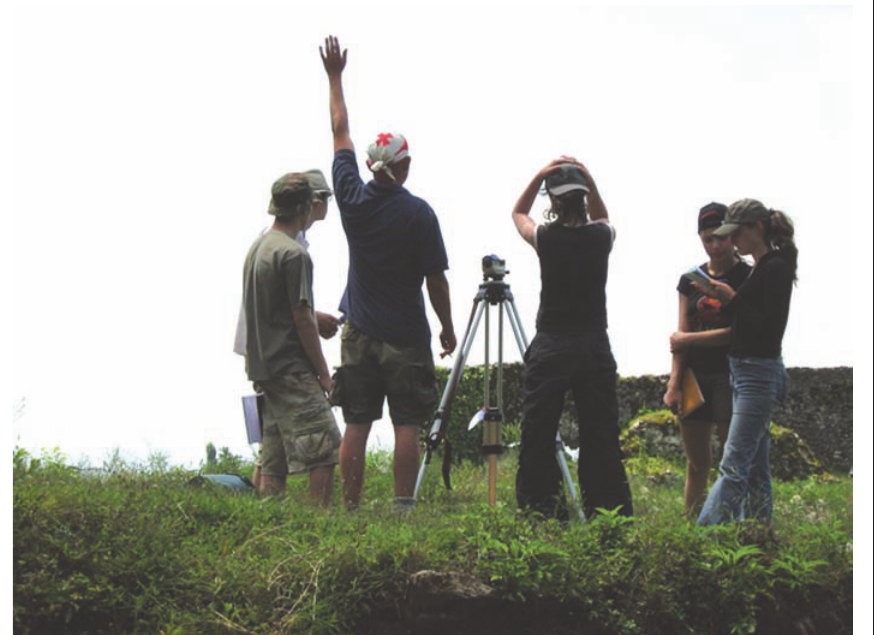
Figure 2 Georgian and British students undertake an exercise using a Dumpy